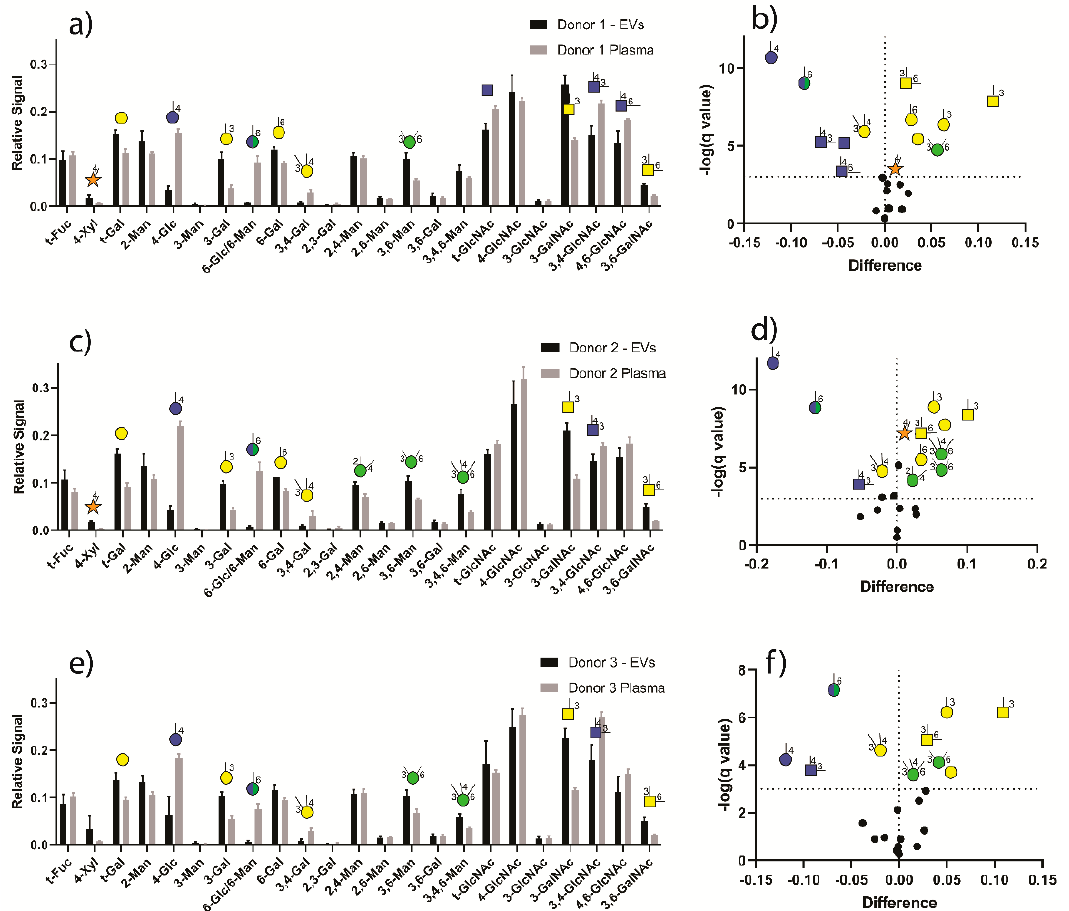
Figure 5. Comparison of EV vs. plasma glycan node profiles from three donors. Data represent extracted ion chromatogram (XIC) peak areas for each hexose or N-acetylhexosamine (HexNAc) within each sample that were normalized to the sum of all hexose or HexNAc XIC peak areas for that sample. Glycan nodes that were significantly different with regard to their relative abundance in EVs vs. plasma are summarized in the volcano plots ( b , d , f ) and depicted as their cartoon representations (defined by the x-axis in each bar graph ( a , c , e )). For each glycan node, significant differences were determined by the Student’s t-test without assuming equal variance between groups. To correct for multiple comparisons, the false discovery rate was set at 0.1% according to the two-stage step-up procedure of Benjamini, Krieger and Yekutieli. Data represent mean ± s.d. ( n = 8 for EVs and n = 6 for plasma).